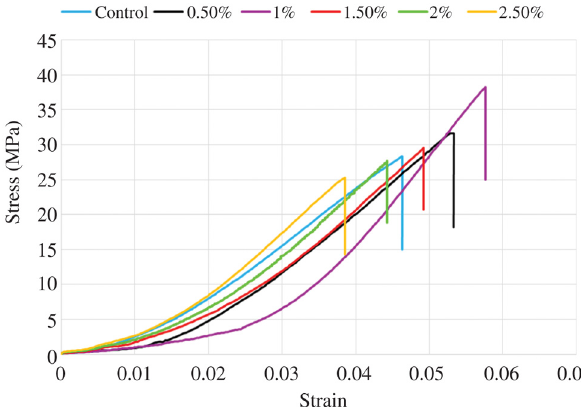
Figure 17: Stress-strain behavior of various compositions of CFR composite.